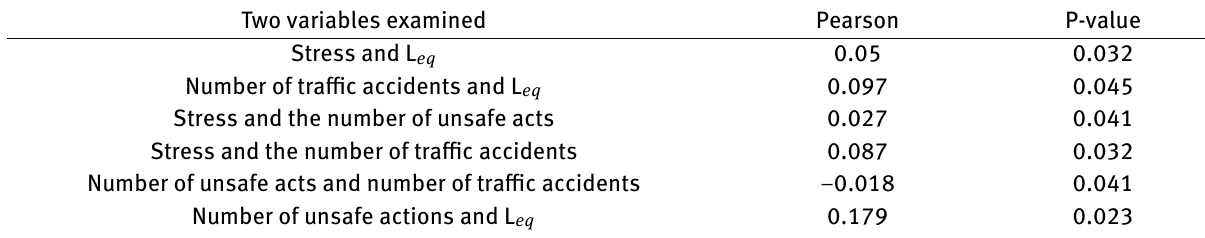
Table 2: The results of the correlation test in examining the relationship between the main variables of the research with each other Two variables